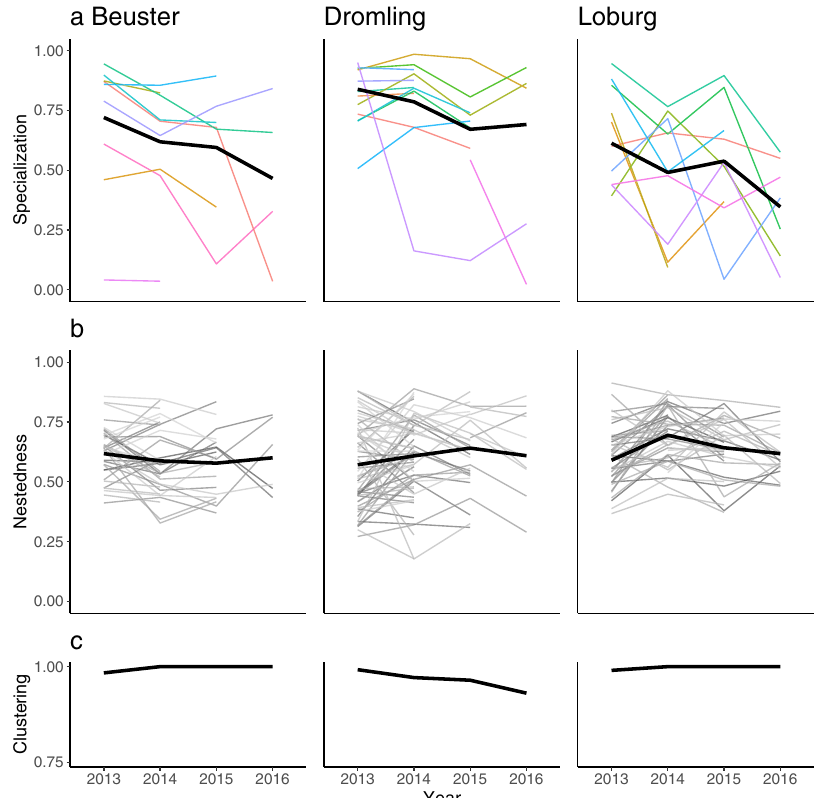
Fig. 3 Individual and population niche con fi guration metrics over time. Specialization ( a ), nestedness ( b ), and clustering ( c ) indices for three populations of white storks during the breeding season (Apr – Aug) over four years (2013 – 2016). Bold black lines represent population-level means. Thin colored/grey lines indicate individual ( a ) or pairwise ( b ) metrics. Individual colors in ( a ) follow Fig. 2. The specialization metric has a high overall repeatability ( R = 0.49). All metrics range from 0 (low) to 1